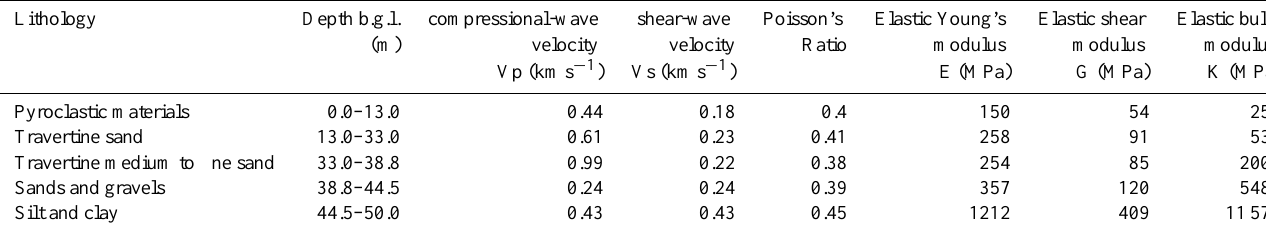
Table 3. Elastic properties defined by cross hole.